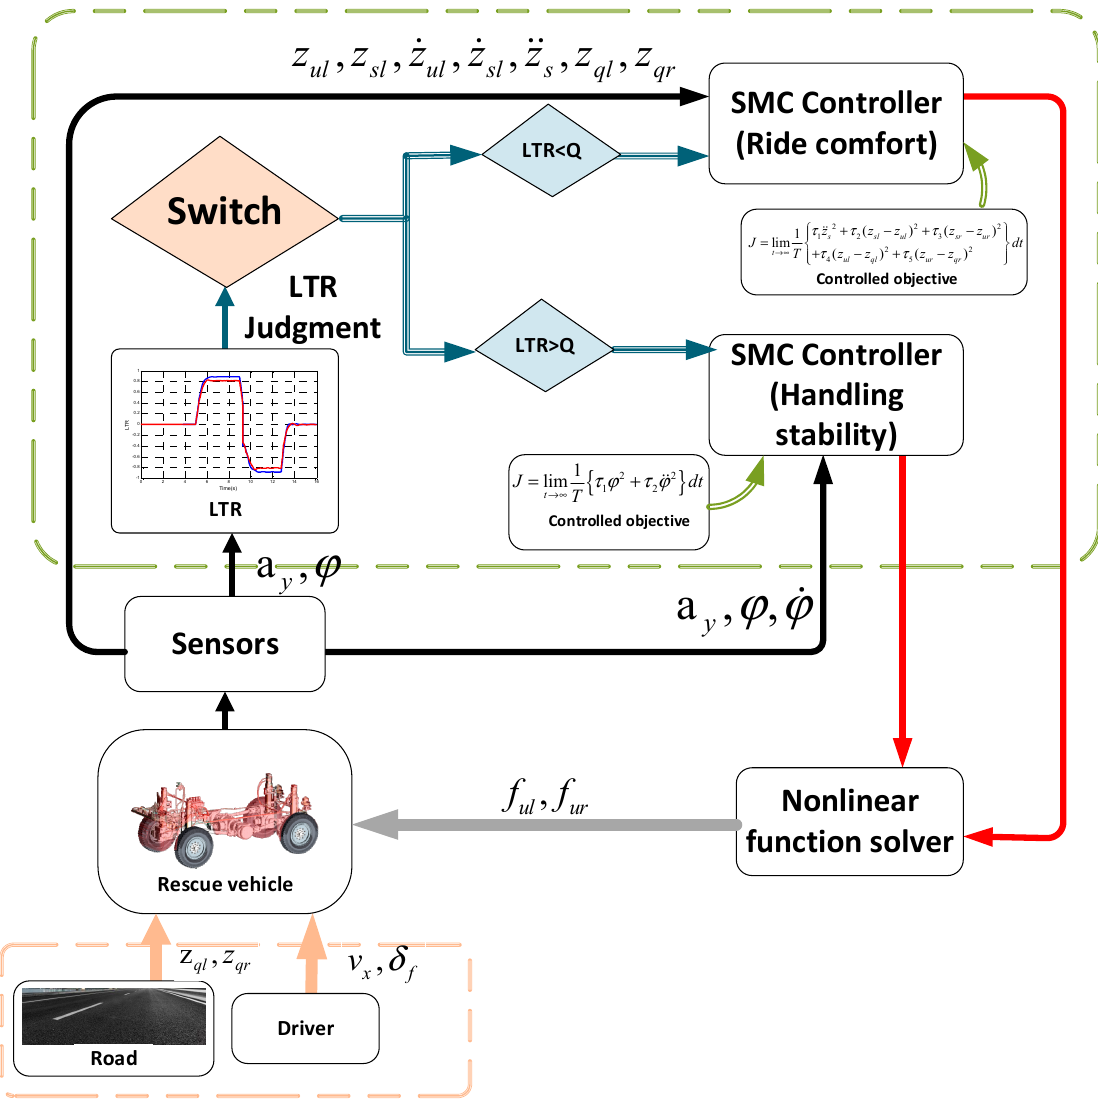
Figure 5. Sliding mode switch control strategy of adjustable hydro-pneumatic suspension.